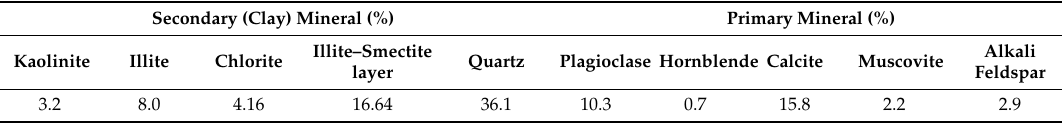
Table 2. Mineral composition of the soil sample.